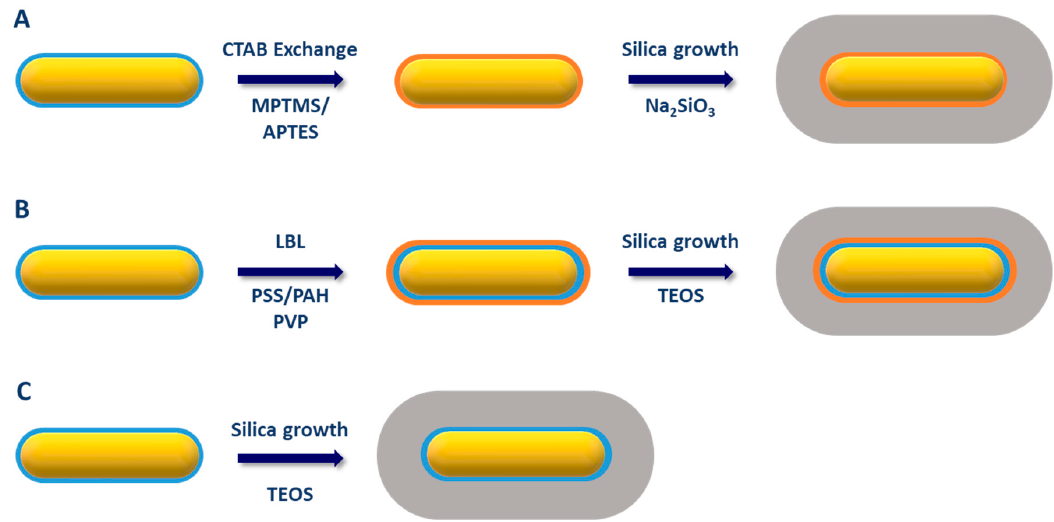
Figure 5. Strategies commonly used for AuNRs capping by silica. ( A ) CTAB exchange by a functional primer followed by silica growth, ( B ) coating through a primer on top of CTAB bilayer then silica growth, and ( C ) direct coating of silica on CTAB-stabilized AuNRs.